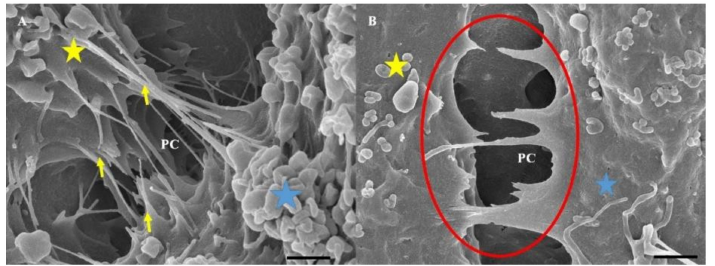
Figure 4. High-resolution scanning electron microscopy (HR-SEM) micrographical representation of the morphological deformation of cell-cell connections between adjacent BECs upon the chemi- cal perturbation of actin polymerization utilizing a known depolymerizing agent, Cytochalasin D. ( A ) Indicates the numerous TENT interactions across the PC space between two bEnd5 cells. The micrograph clearly depicts the extensive formation of tethering-NTs which are naturally taut and project across the PC space; ( B ) A micrograph demonstrating the depolymerizing effect of Cytocha- lasin D on F-actin of bEnd5 cells where TENT formation is compromised forming thick, brittle-type NTs, as well as a distinct decrease in the TENT formation. An observable decrease in the number of NVs on the treated BEC membrane was seen, compared to the numerous NVs that were located on the control BEC membranes in ( A ). The yellow star represents cell 1, the blue star represents cell 2, and the paracellular space is denoted by PC .